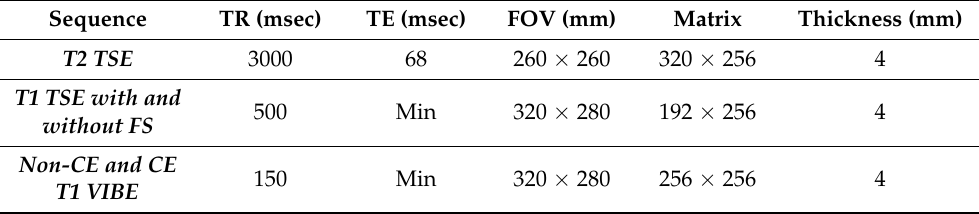
Table 1. MRI Protocol. FOV: Field Of View; TSE: Turbo Spin Echo; TE: Echo Time; TR: Repetition